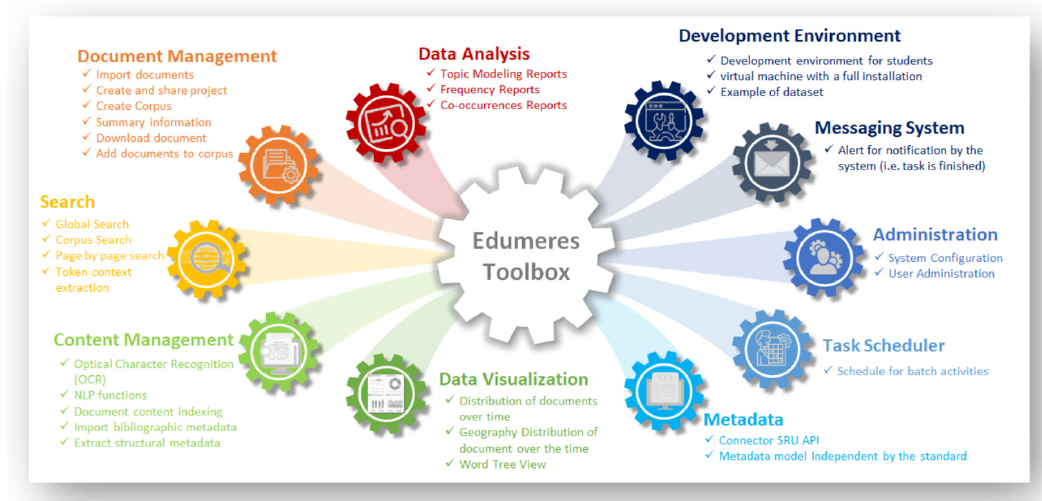
Figure 2. Functionalities of the Edumeres Toolbox.